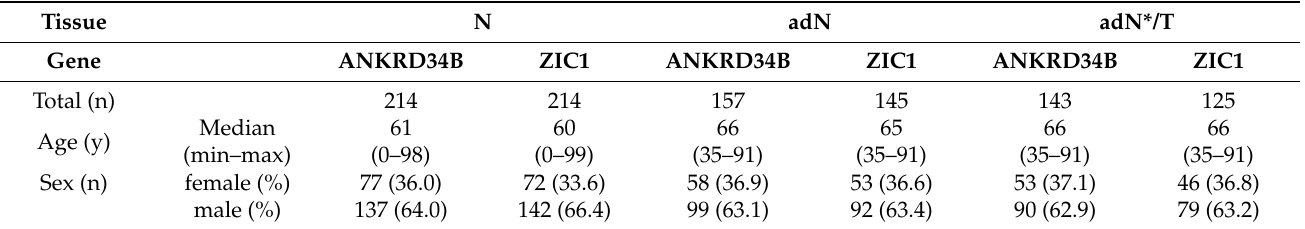
Table 4. Tissue characteristics of normal autopsy (N), tumor adjacent normal (adN) and tumor tissues